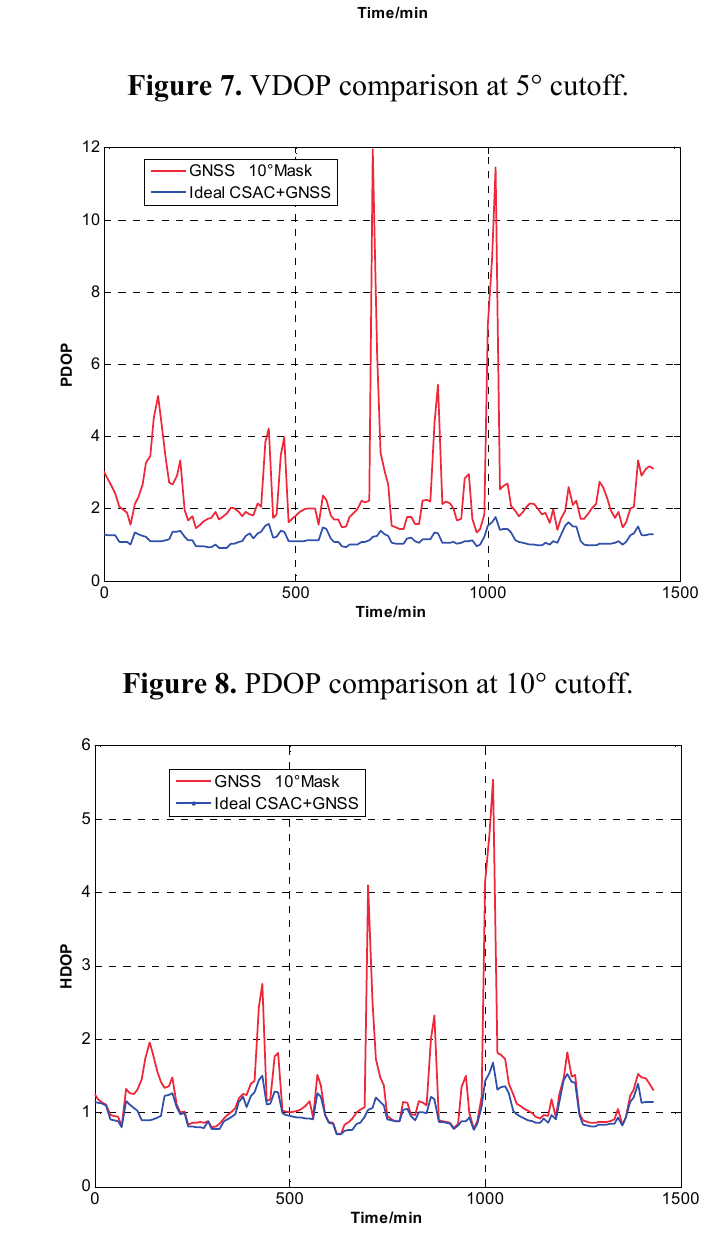
Figure 9. HDOP comparison at 10°